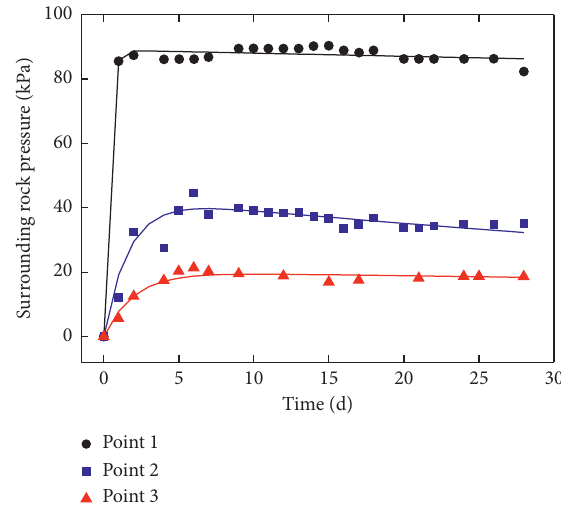
Figure 5: Measured rock